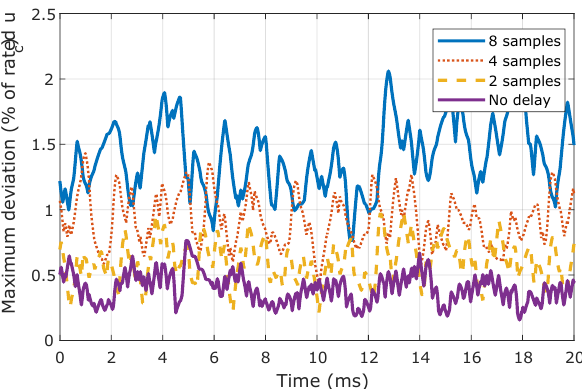
Figure 9. Maximum deviation to the average capacitor when the sorting uses measurements with and without delays. Capacitor rated voltage of 170 V and sampling period of 100 µs.